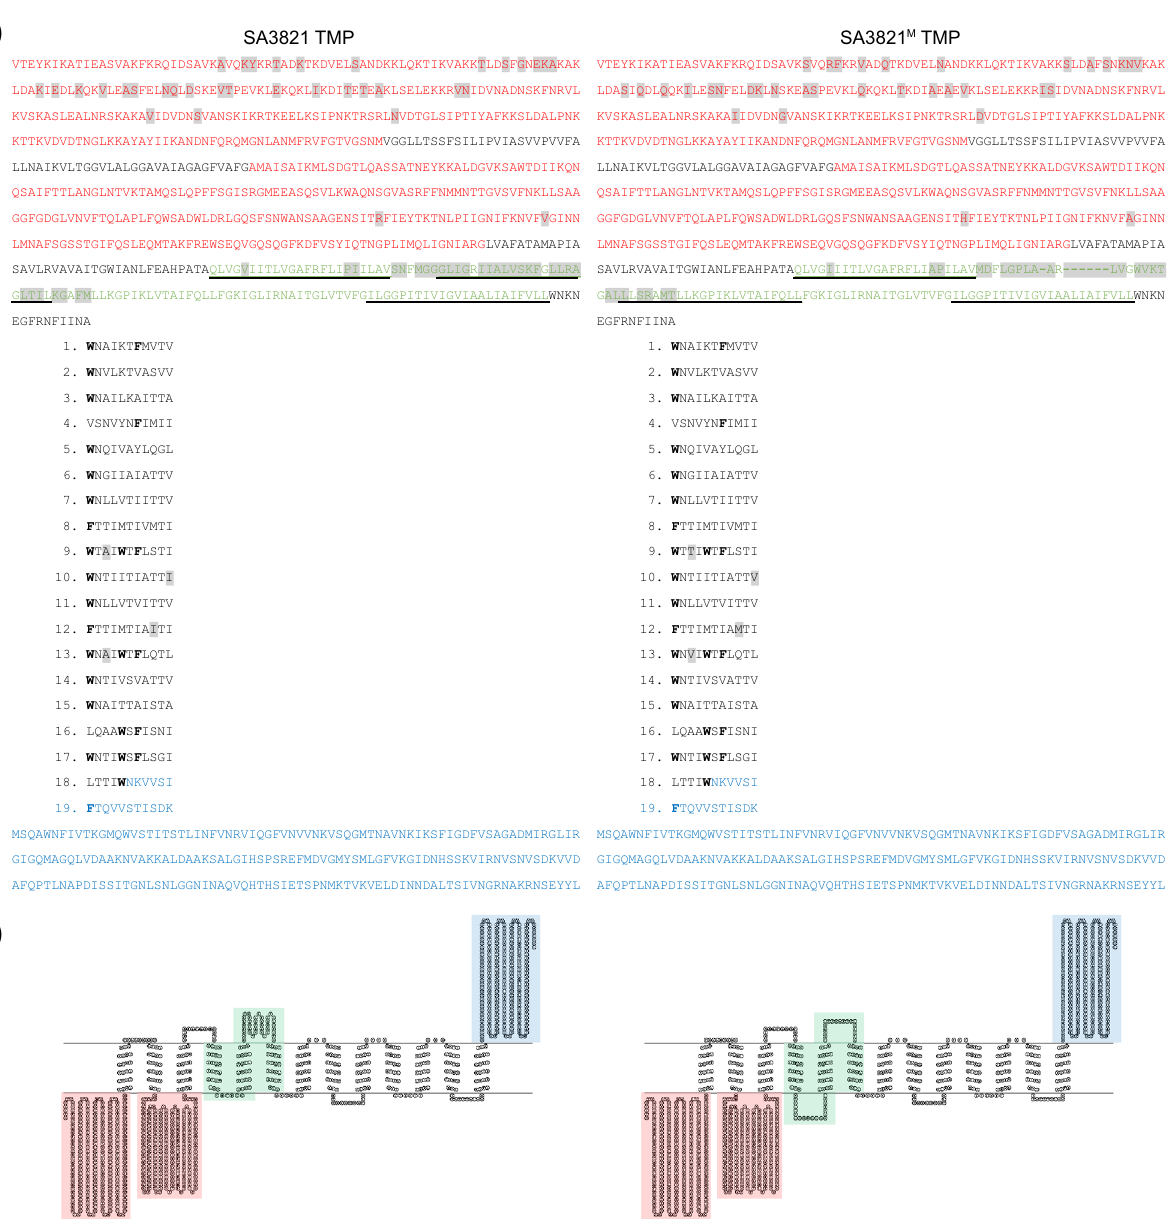
Figure 6. Amino acid sequence and topology predictions for SA3821 TMP and SA3821 M TMP. ( a ) TMP amino acid sequences for SA3821 and SA3821 M with 19 tandem repeats indicated numerically. a.a. deletions are indicated by hyphens. The positions of a.a. substitutions are indicated with a gray background. The predicted N-terminal, C-terminal hydrophilic, and changed central hydrophobic regions are indicated by red, blue, and green, respectively. Sequences of fourth-to-sixth transmembrane-spanning regions are underlined. ( b ) The topology model of TMP with the color-highlighted as in panel ( a